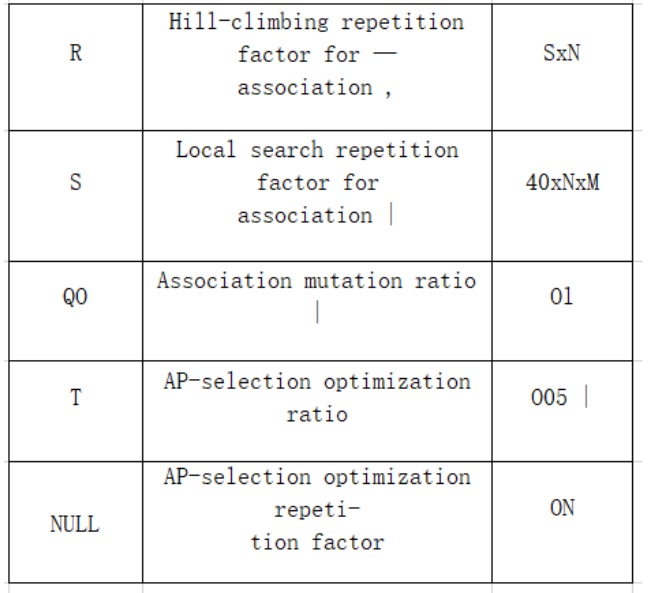
Figure 27. Excel output for scanned table image 5 by our algorithm.